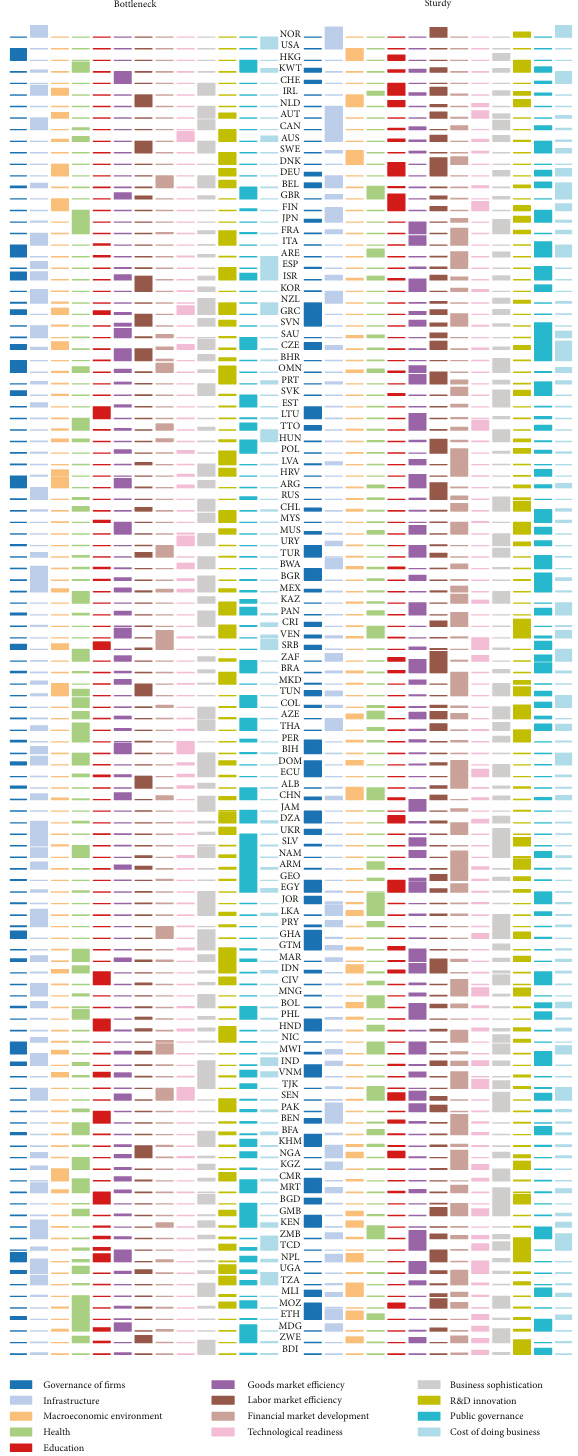
Figure 13: Sturdy policies and bottlenecks by development indicators by country (sorted by purchasing power parity income per capita). Bottlenecks: fragile policies in the 5 th percentile of relative priorities. Sturdy: resilient policies in the 95 th percentile of relative